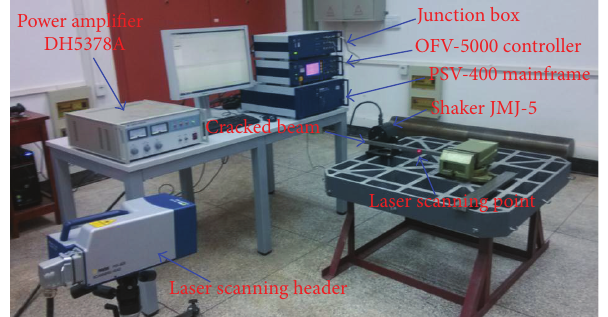
Figure 9: Experimental